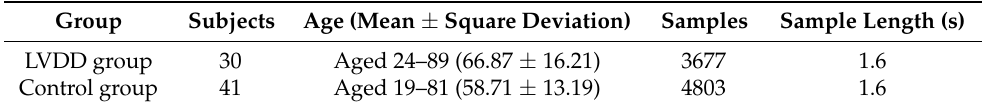
Table 2. The number of HS samples in different